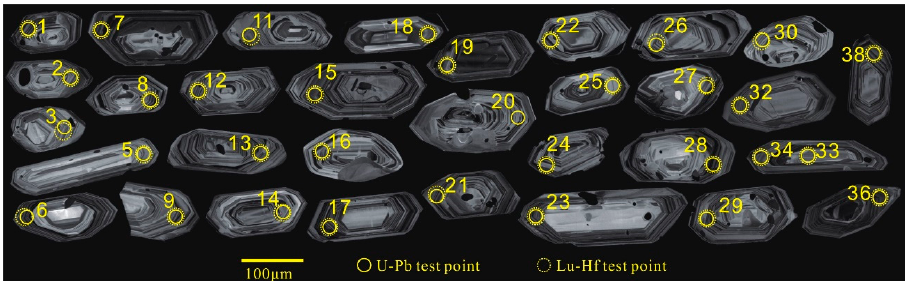
Figure 3. Zircon Cathodoluminescence (CL) images of the Yanghuidongzi porphyry. The 1–38 represents laser ablation spot number. represents laser ablation spot